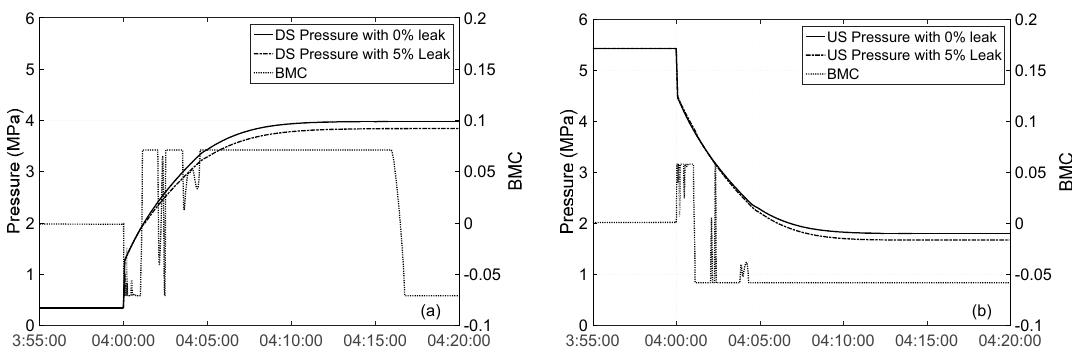
Figure 5. BMC behaviour for flow decrease transient initiated at: ( a ) the downstream end; and ( b ) upstream end with perfect data.